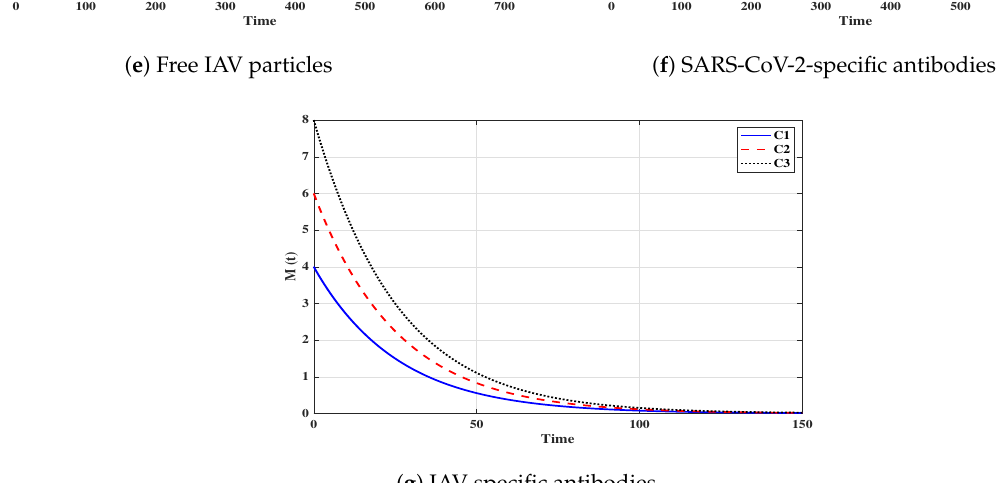
Figure 7. Solutions of system (3) with initials C1–C3 tend to Ξ 5 = ( 1.25,2.84,0.63,1.67,2.5,2.82,0 ) when (cid:60) 5 > 1, (cid:60) 1 / (cid:60) 2 > 1 and (cid:60) 7 ≤ 1 (Situation